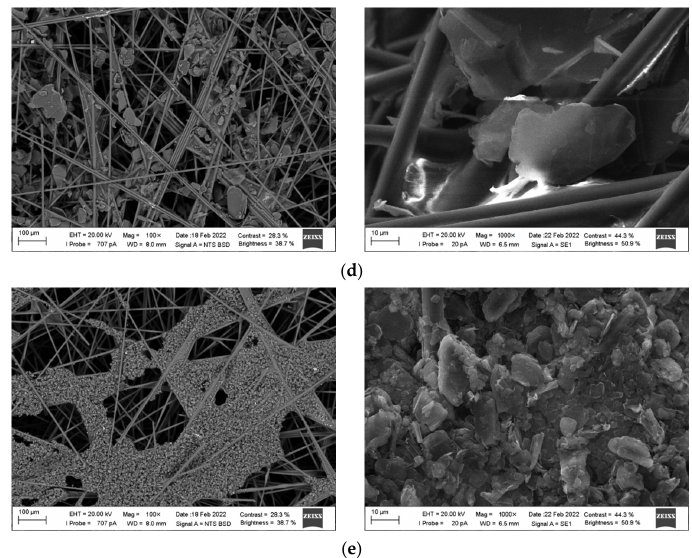
Figure 2. SEM images of the bare CP ( a ) and the CP modified with different carbon materials: MWCNTs ( b ), CB ( c ), GR ( d ) and GrP ( e ). MWCNTs ( b ), CB ( c ), GR ( d ) and GrP ( e ).